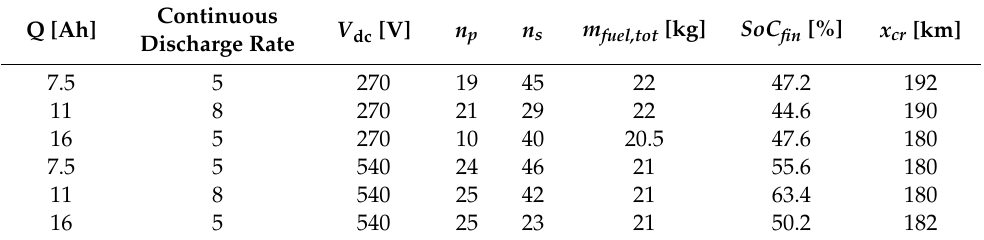
Table 4. Problem 1 for di ff erent cells and the DC-link voltage.